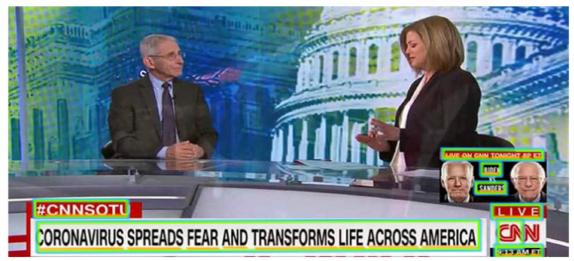
Figure 2. A Twitter image with its optical character recognition (OCR) bounding boxes, as analyzed by Google Cloud Vision